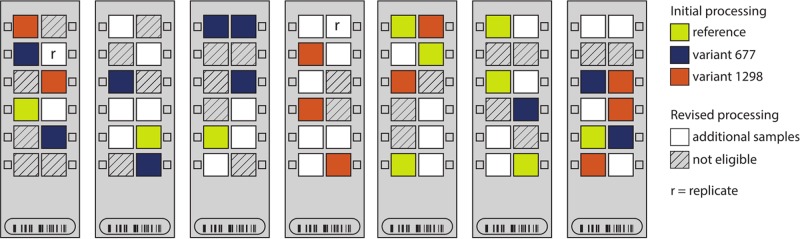
Sample distribution on seven Illumina Infinium HumanMethylation450 chips. The locations of the placental samples used in the initial processing (n = 30 samples) are indicated by color: yellow – reference; blue – variant 677; and orange – variant 1298. In the revised processing, all other placental samples (white) were genotyped for MTHFR c.677 (rs1801133) and c.1298 (rs1801131) and added to the processing (n = 59 samples). Non-placental and poor-quality samples were ineligible for inclusion in the revised processing (hashed).